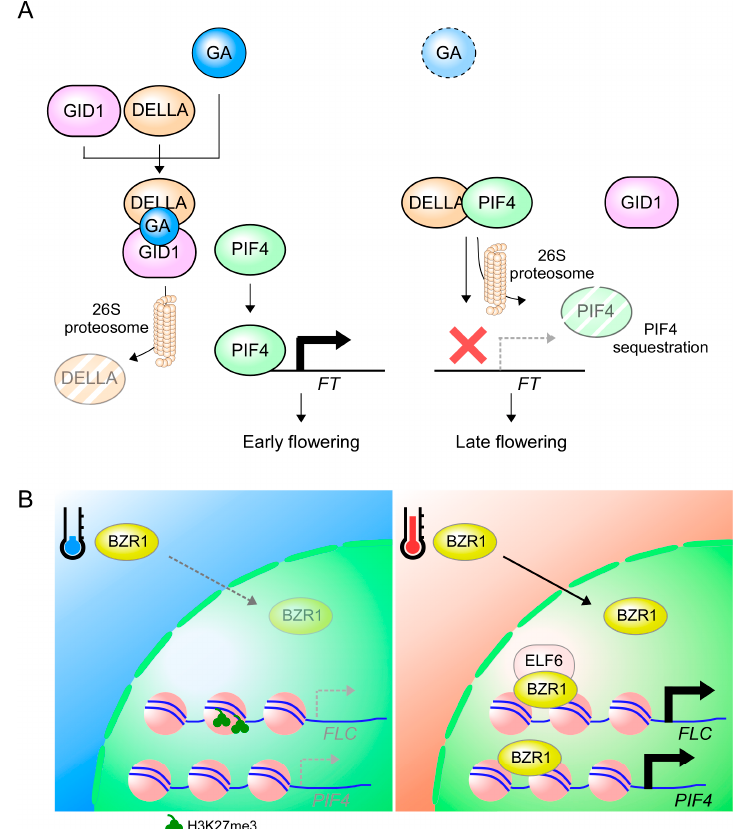
Figure 4. Hormone-regulated floral regulation. ( A ) Role of GAs in the regulation of flowering. In the presence of GA (left panel), GA induces the binding of GID1 with DELLA proteins, which initiates the ubiquitination and subsequent degradation of DELLA proteins. As a result of DELLA degradation, PIF4 can bind to the FT locus and induce FT expression, which leads to early flowering. However, in the absence of GAs, DELLA proteins induce the 26S proteasome-mediated degradation of PIF4 (right panel). As a result, PIF4 cannot bind to the FT locus and FT expression cannot be induced, resulting in delayed flowering. Arrows and dashed arrows denote activation and inability to activate, respectively. ( B ) The cellular localization of BZR1 is regulated by ambient temperature. At low ambient temperatures (blue thermometer), BZR1 is mainly localized in the cytoplasm, whereas at warm temperatures (red thermometer), BZR1 is localized in the nucleus and it interacts with ELF6 and allows rapid activation of FLC through the removal of H3K27me3. BZR1 also binds to the PIF4 promoter to activate its transcription. Faint oval and fragmented ovals indicate proteins with low abundance and degraded protein, respectively.